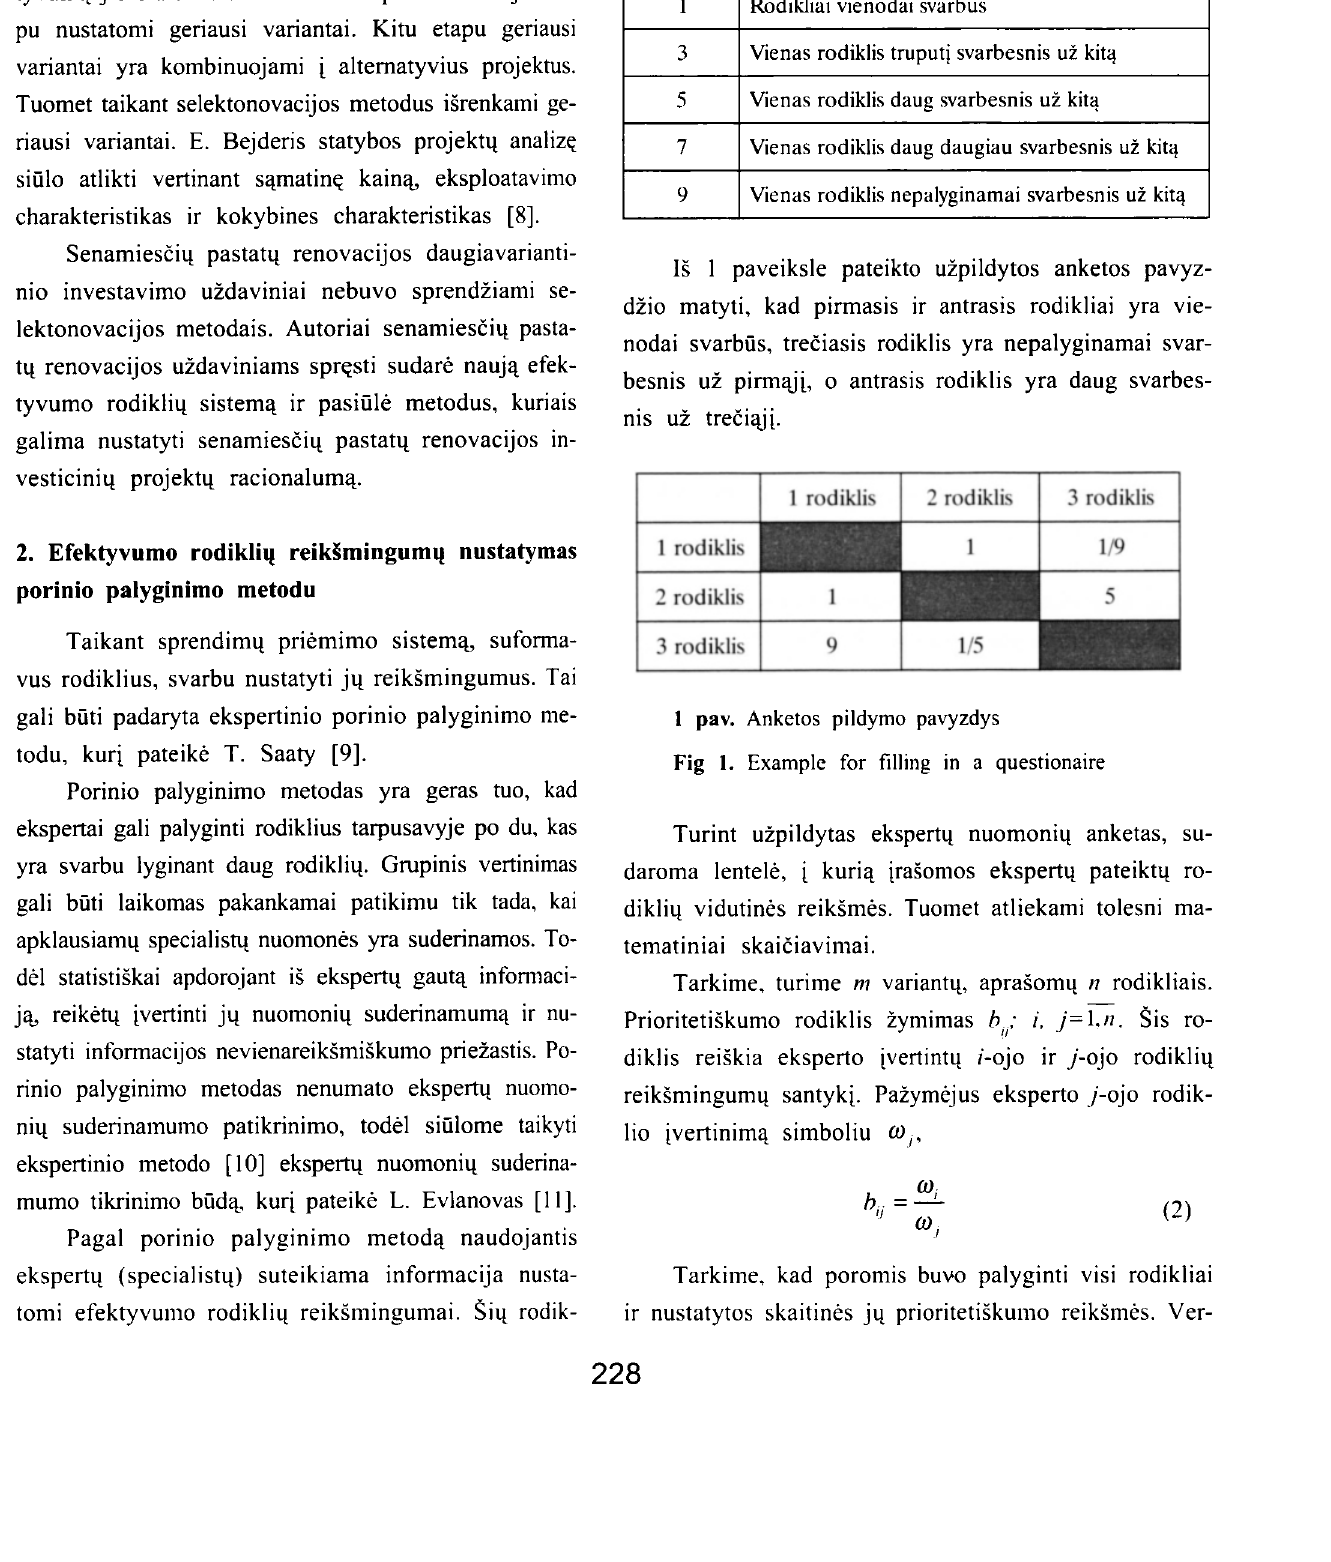
Table 1. Scale of importances given by T. Saaty [9] Svarbumo lygis